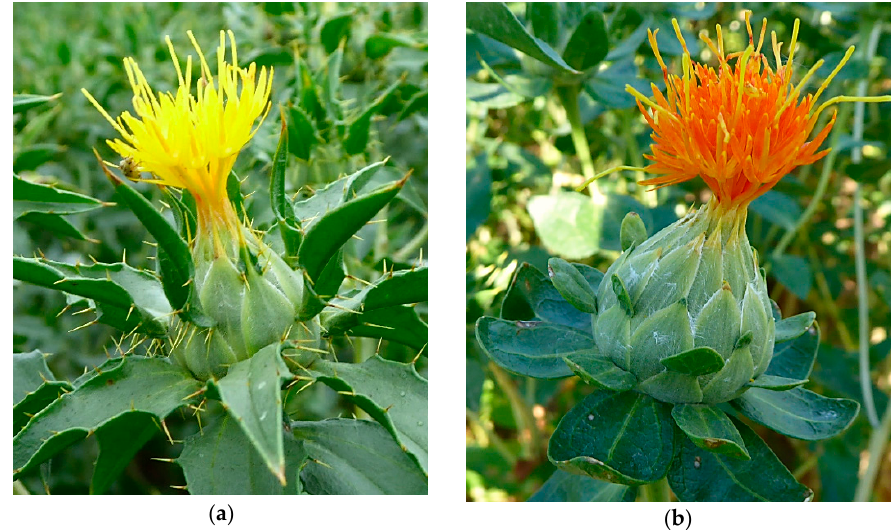
Figure 1. The two cultivars of Carthamus tinctorius L. used in the field trials: ( a ) German, spiny cultivar; ( b ) Chinese, thornless cultivar.